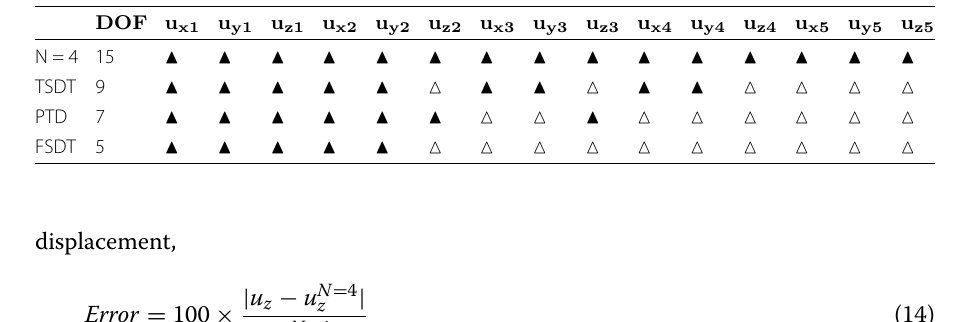
Table 1 Examples of shell models